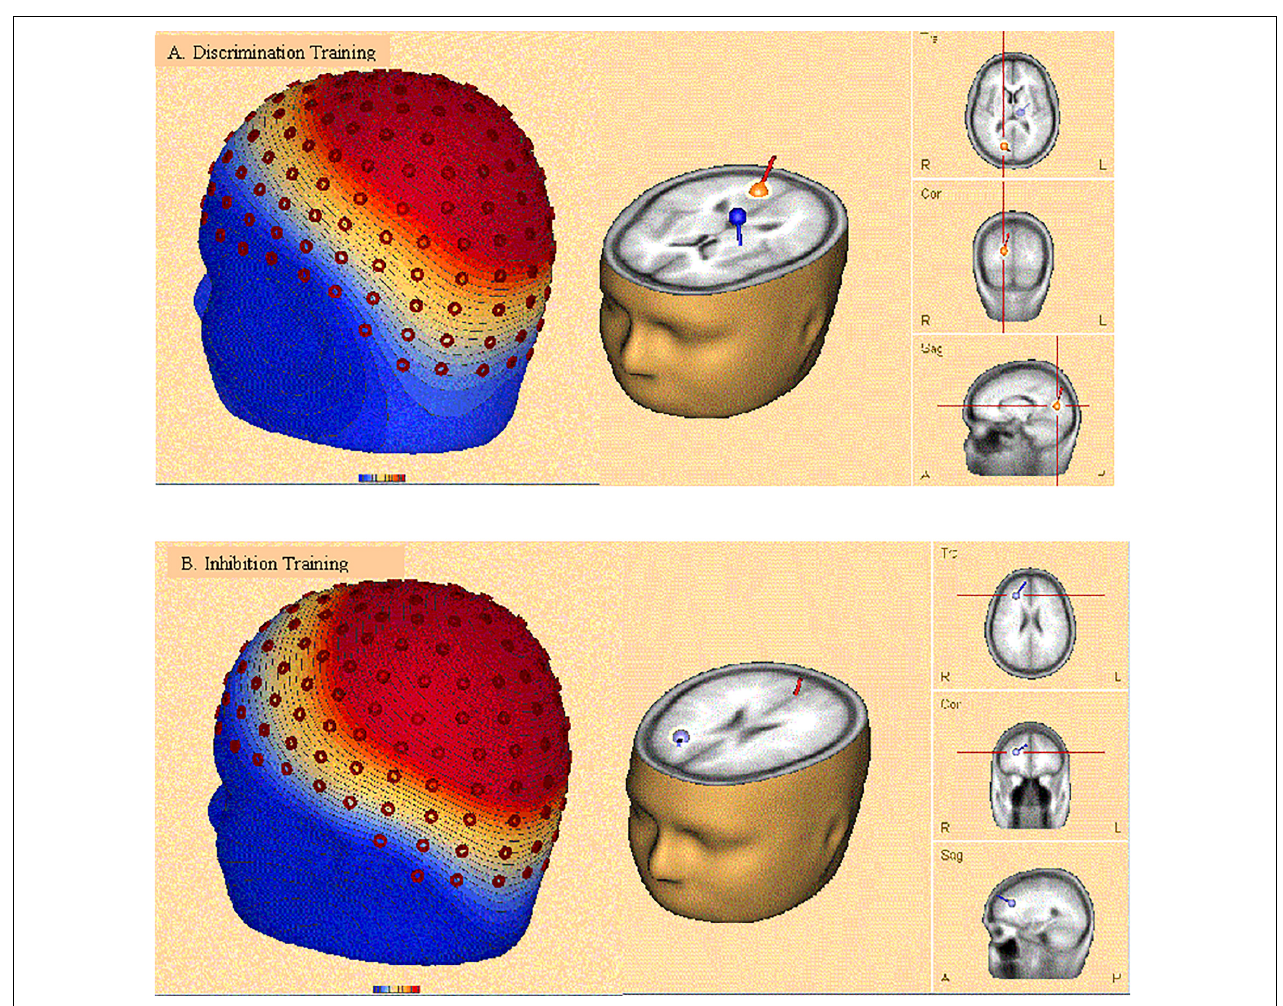
FIGURE 12 | Topographic map (Leftmost image in each panel) and discrete dipole source analysis solution (Rightmost image) performed separately for discrimination training (A) and inhibition training (B) at posttest to incongruent distractors during an epoch 600–700 ms after stimulus onset, corresponding to the RP and P3 ERP components. After discrimination training, the best fitting dipoles were located in the right occipital lobe and the cingulate gyrus. After inhibition training, the best fitting dipoles were located in the right occipital lobe and the medial frontal